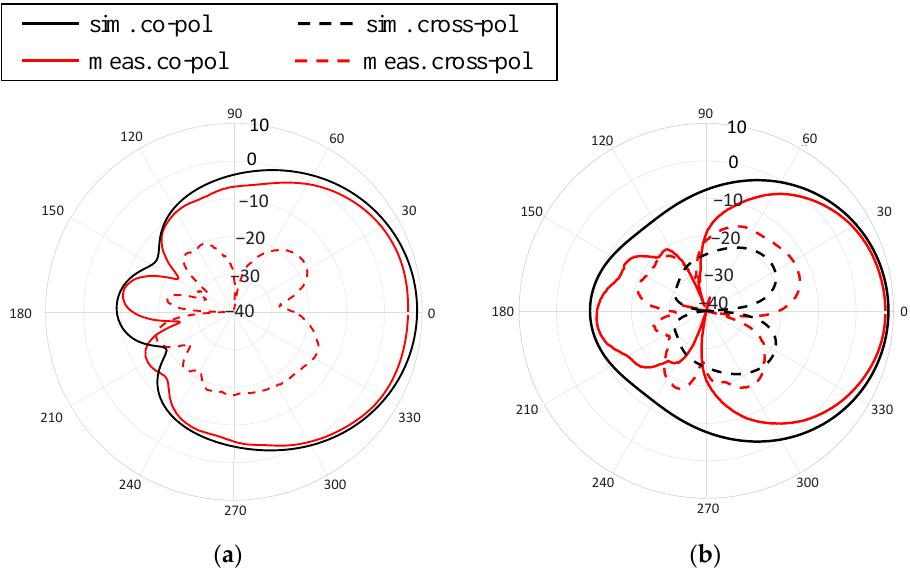
Figure 14. Antenna gain at fundamental frequency (5.8 GHz). ( a ) E plane. ( b ) H plane.